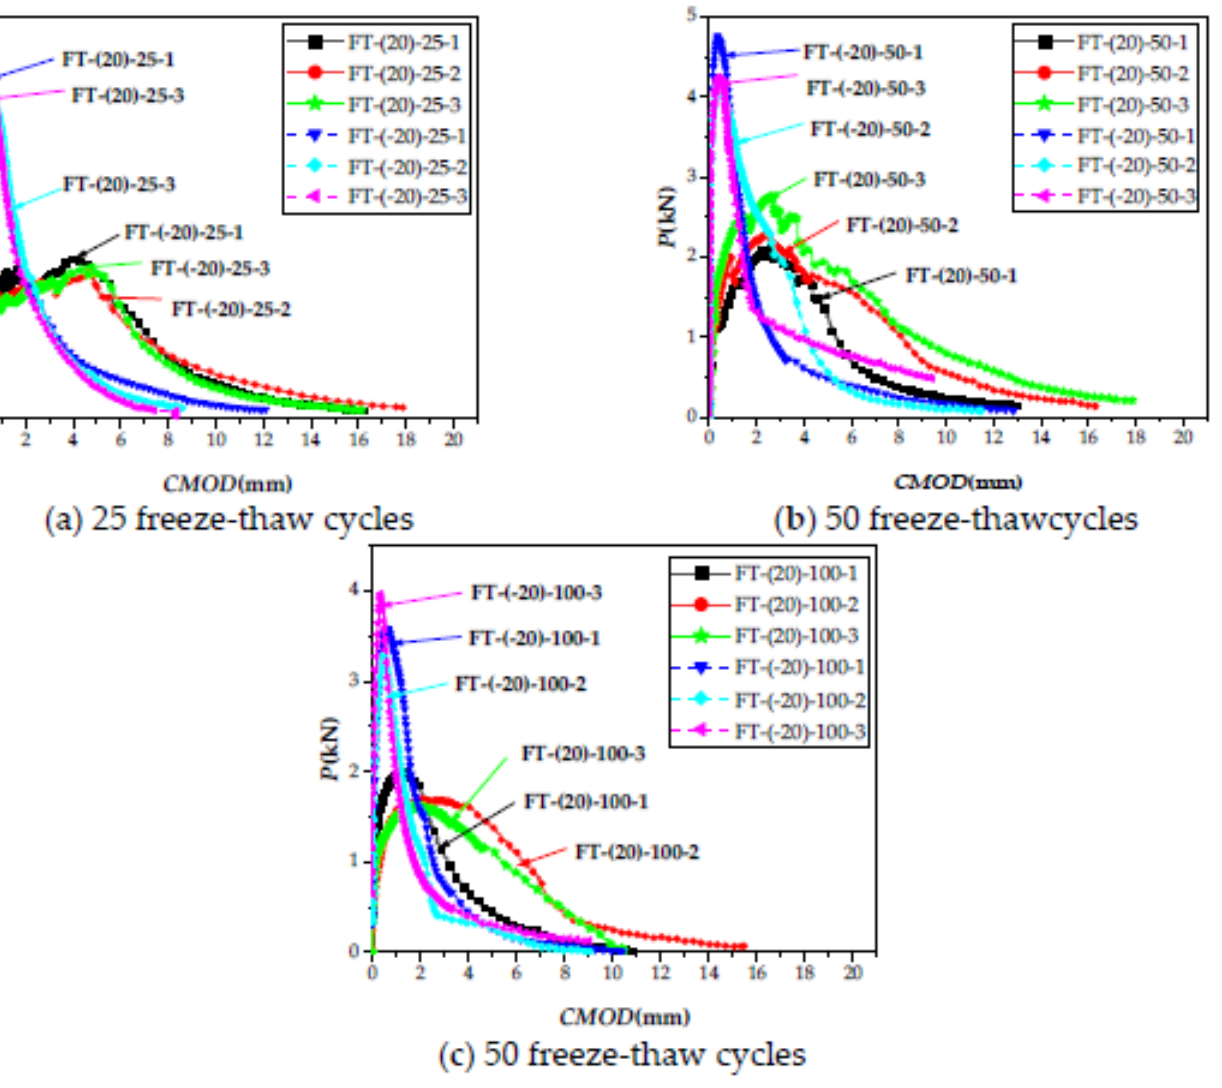
Figure 14. P-CMOD curves under 20 and − 20 °C, loaded after different freeze–thaw cycles. ( a ) 25 freeze-thaw cycles. ( b ) 50 freeze-thaw cycles. ( c ) 100 freeze-thaw cycles. Table 6. ECC fracture properties calculation table after different freeze–thaw cycles.